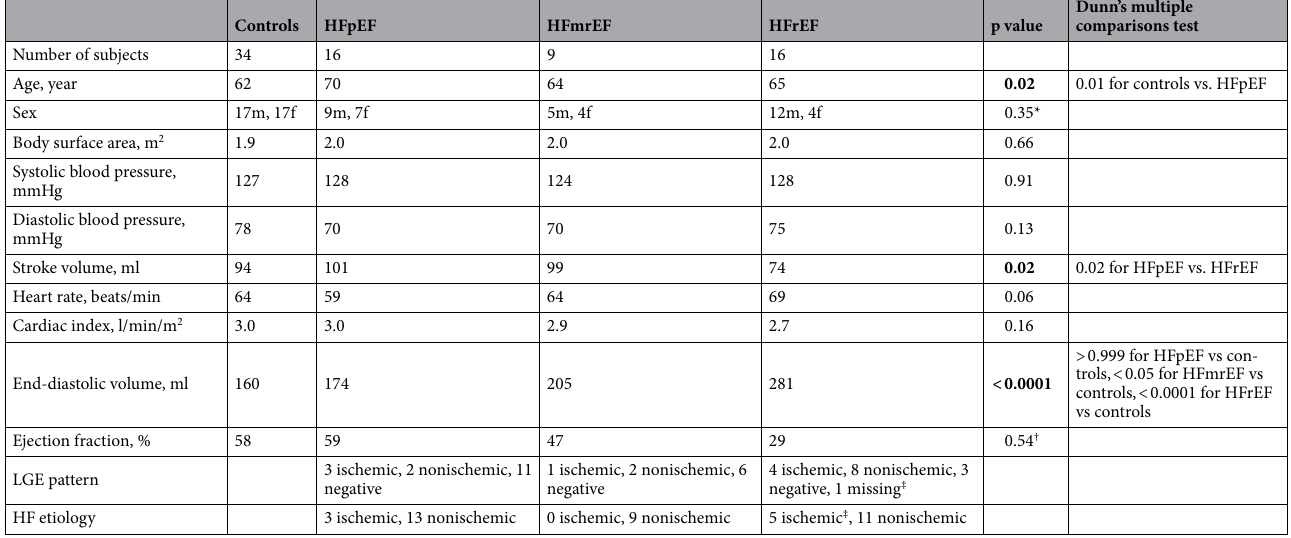
Table 1. Subject characteristics. Significant values are in bold. Average values. *Comparison between controls and aggregated patients, computed using Fisher’s exact test. † Comparison between controls and HFpEF, classified as ischemic due to dilated ventricle with regional hypo/akinesia in distal parts of the LAD territory with no global